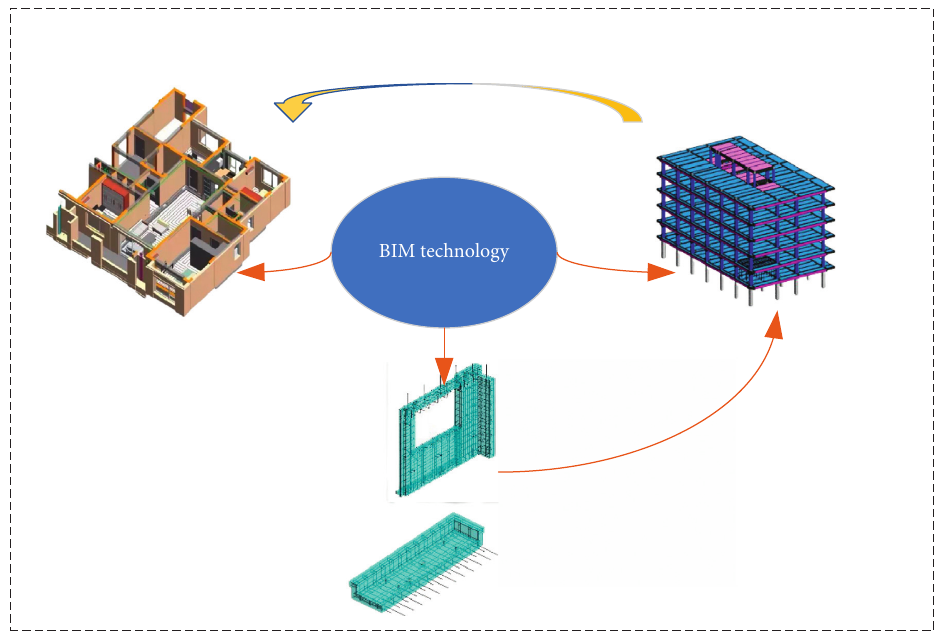
Figure 6: BIM model of assembly building turning cloud.